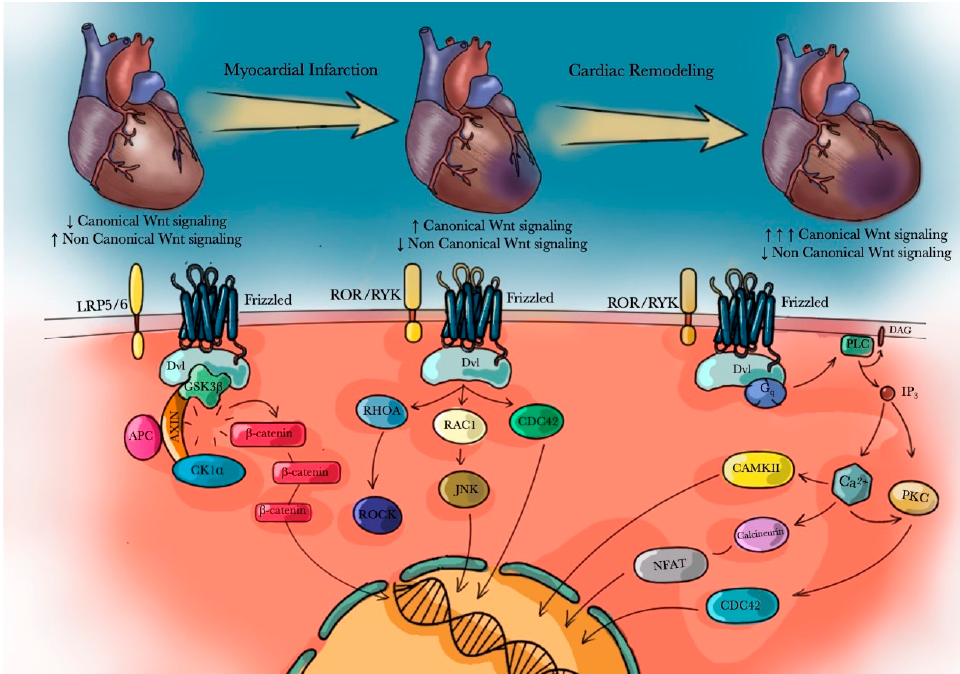
Figure 2. Schematic summary of canonical and non-canonical Wnt/ β catenin signaling pathways activation in both mature healthy heart and under pathological conditions .